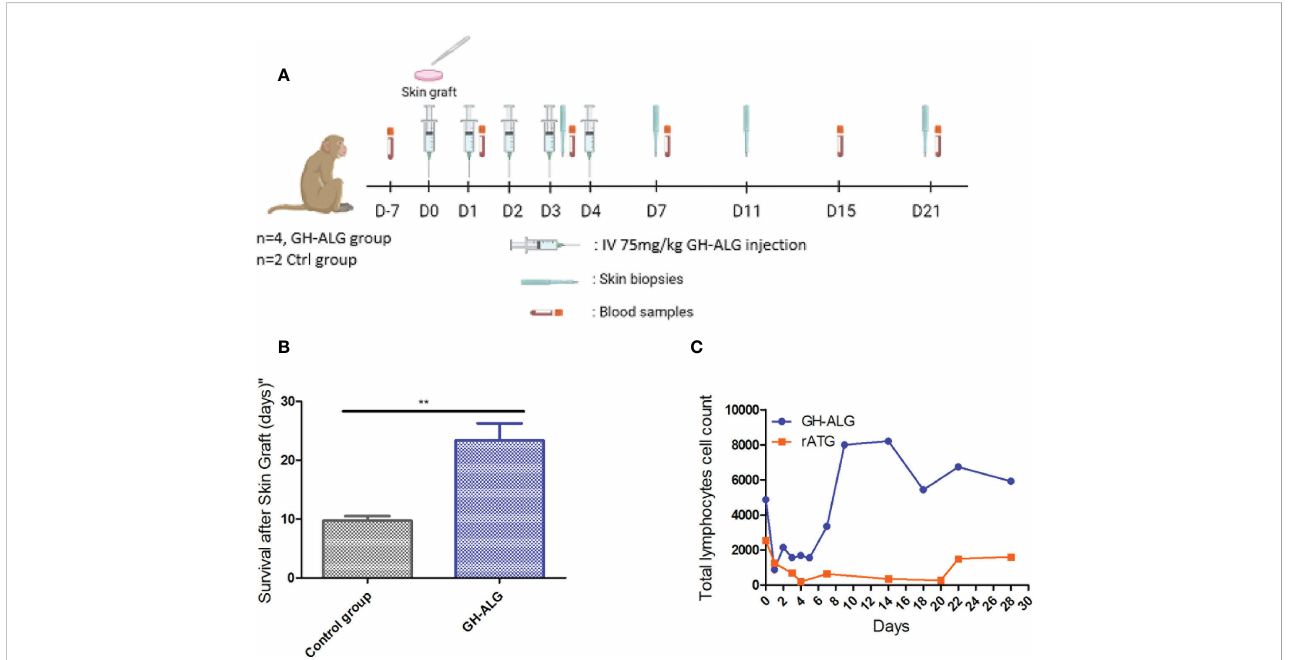
FIGURE 4 In vivo ef fi cacy of anti-lymphocyte IgG in NHP. (A) Timeline of the NHP skin graft study. (B) Skin grafts were performed on anesthetized animals on Day 0. After back skin shearing and asepsis, the animals were grafted in pairs (back skin collection using a 20 mm diameter template, followed by grafting and skin graft suturing). In the back of each animal, three grafts were performed: one autograft (as a control) and two pairwise allografts (one animal received skin transplants of his congener). Four cynomolgus monkeys intravenously received GH-ALG at 75 mg/kg once a day for 5 consecutive days. Four cynomolgus monkeys were used as controls and did not receive treatment. Skin graft rejection was considered when the area of the necrotized part covered the full graft, and the whole graft site hardened. (C) GH-ALG and rabbit ATG-induced T-cell depletion in macaques. Cynomolgus monkeys (n=9) received I.V. daily doses of 50 mg/kg of GH-ALG for 5 days. Cynomolgus monkeys (n=2) received I.V. daily doses of 5 mg/kg of rabbit ATG for 5 days. ** between 0.001 and